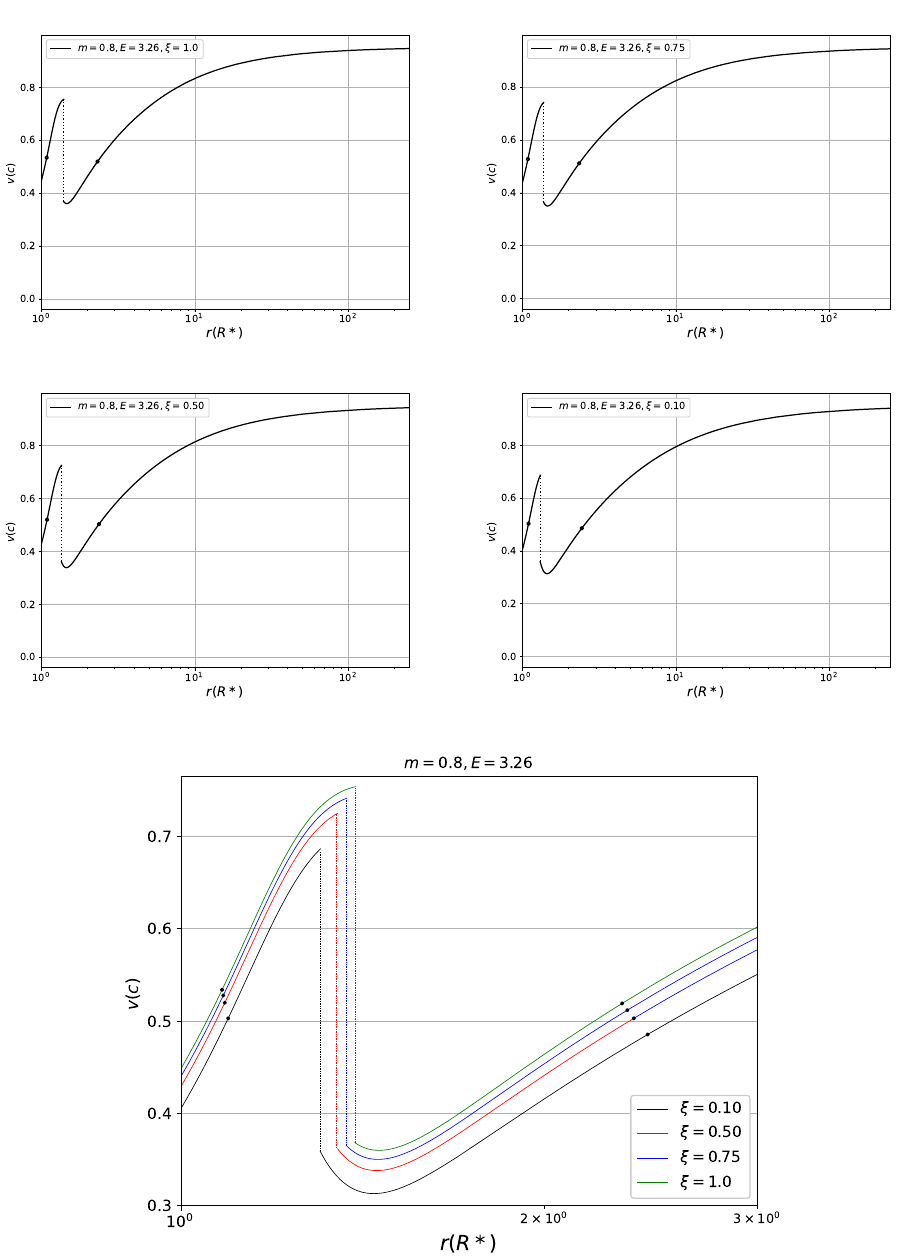
Figure 9. Jet velocity v for different choices of ξ = 1.0 ( top left ), 0.75 ( top right ), 0.50 ( middle left ), and 0.10 ( middle right ) with fixed values of m = 0.8 and E = 3.26. The whole range of ξ produces shock in the jet as the collimation is strong. In the bottom panel , we overplot these profiles and zoom the region near the surface of the star to show that the shock gets stronger and is pushed apart as the baryon fraction in the jet